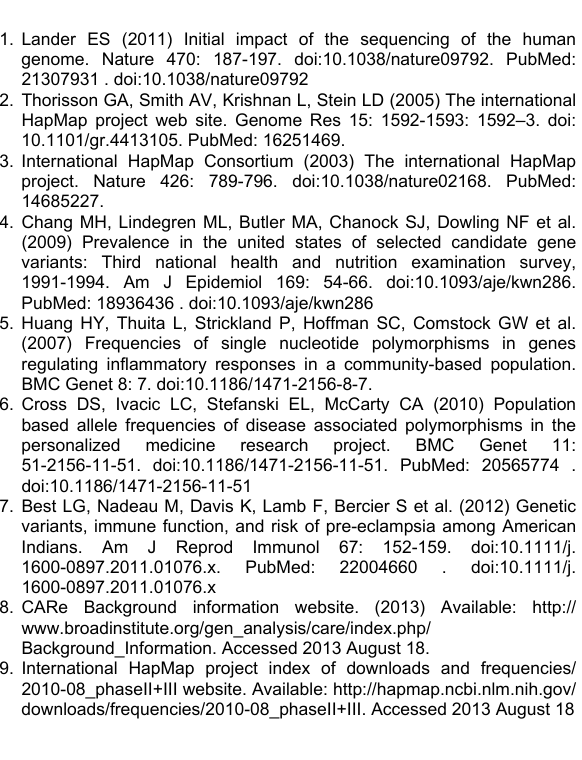
Figure S1. Plot of Principal Components 1 vs 2, showing dichotomized TMCC population and selected comparison populations.